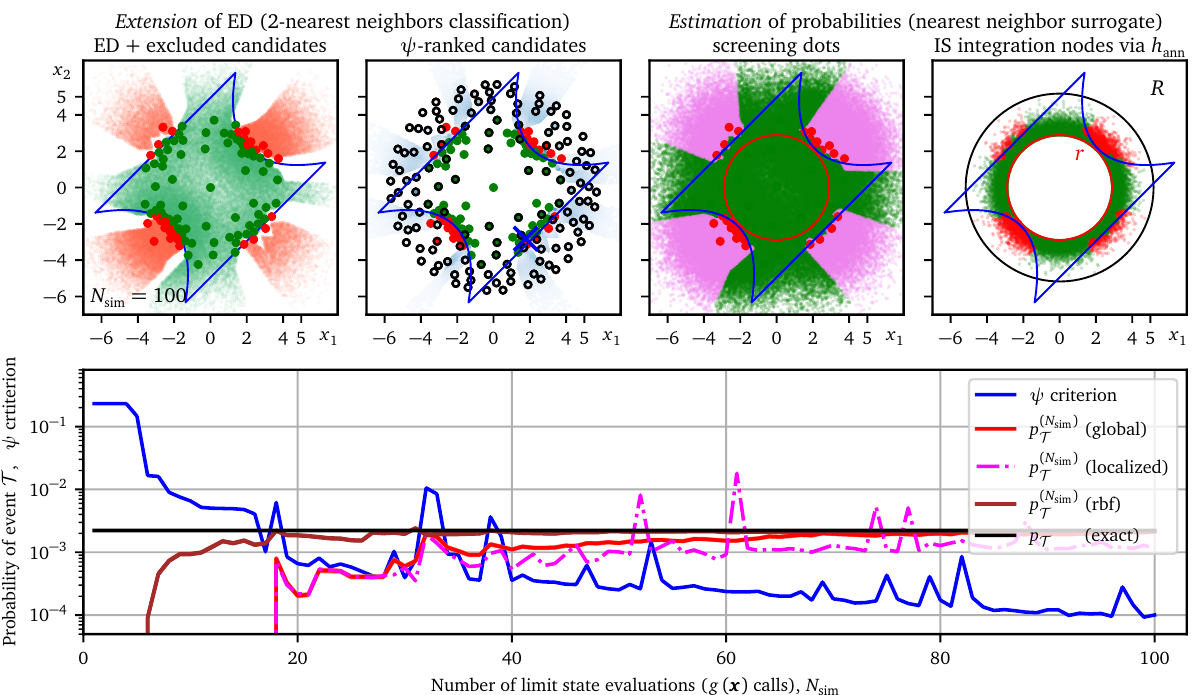
Figure 6. The ”Four branch” problem. The complete evolution of all panels is available as Four Branch video